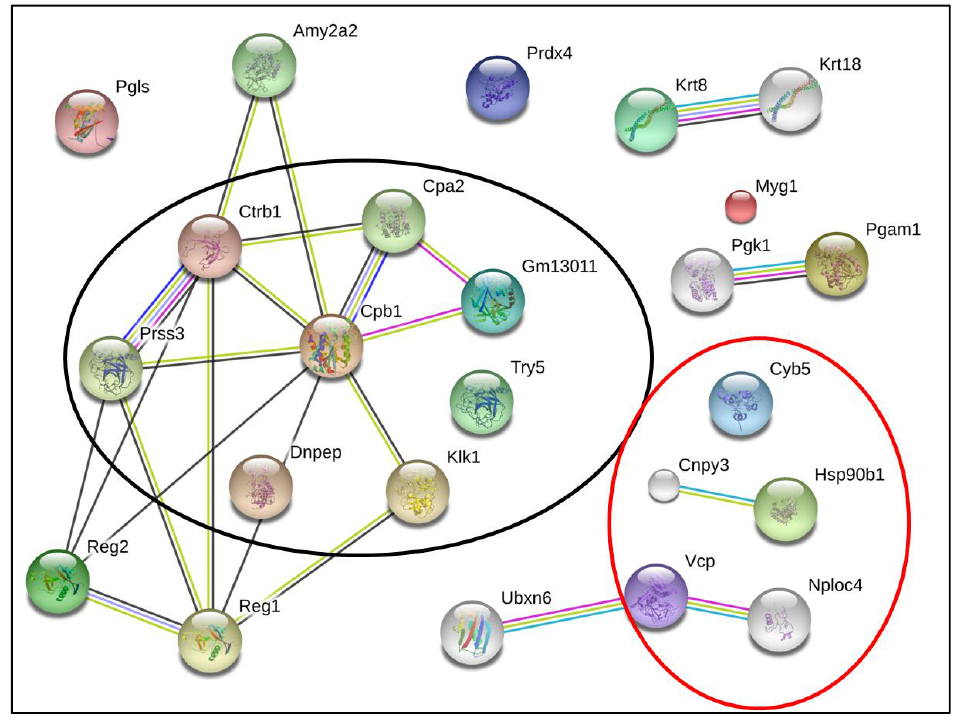
Figure 2. Bioinformatics analysis by Search Tool for the Retrieval of Interacting Genes/Proteins . The list of the identified protein was subjected to STRING (v. 9.05) analysis to reveal functional interactions between the deregulated proteins. Each node represents a protein, and each edge represents an interaction. The original graphic output was modified to fit the proteins, according to their classification under the gene ontology descriptors “Cellular Component”: endoplasmic reticulum (confined within the red circle) and “Molecular Function”: peptidases activity (confined within the black circle) as revealed by the Database for Annotation, Visualization and Integrated Discovery (DAVID) (v. 6.7) annotation